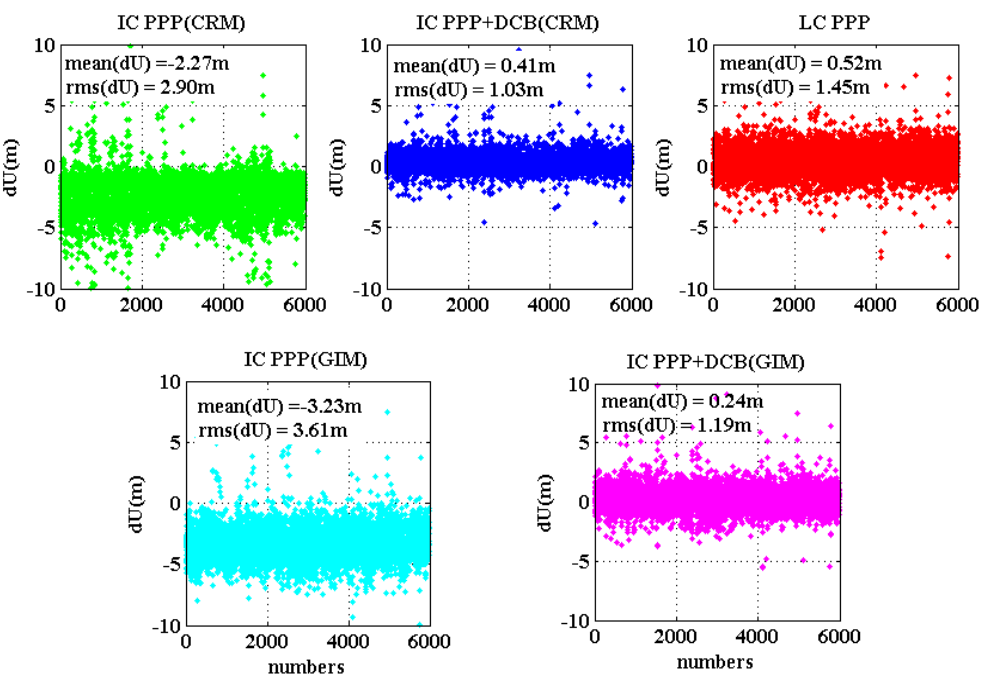
Figure 10. Initial height results for the five PPP schemes. The position of the first three epochs are counted and plotted for all the convergence